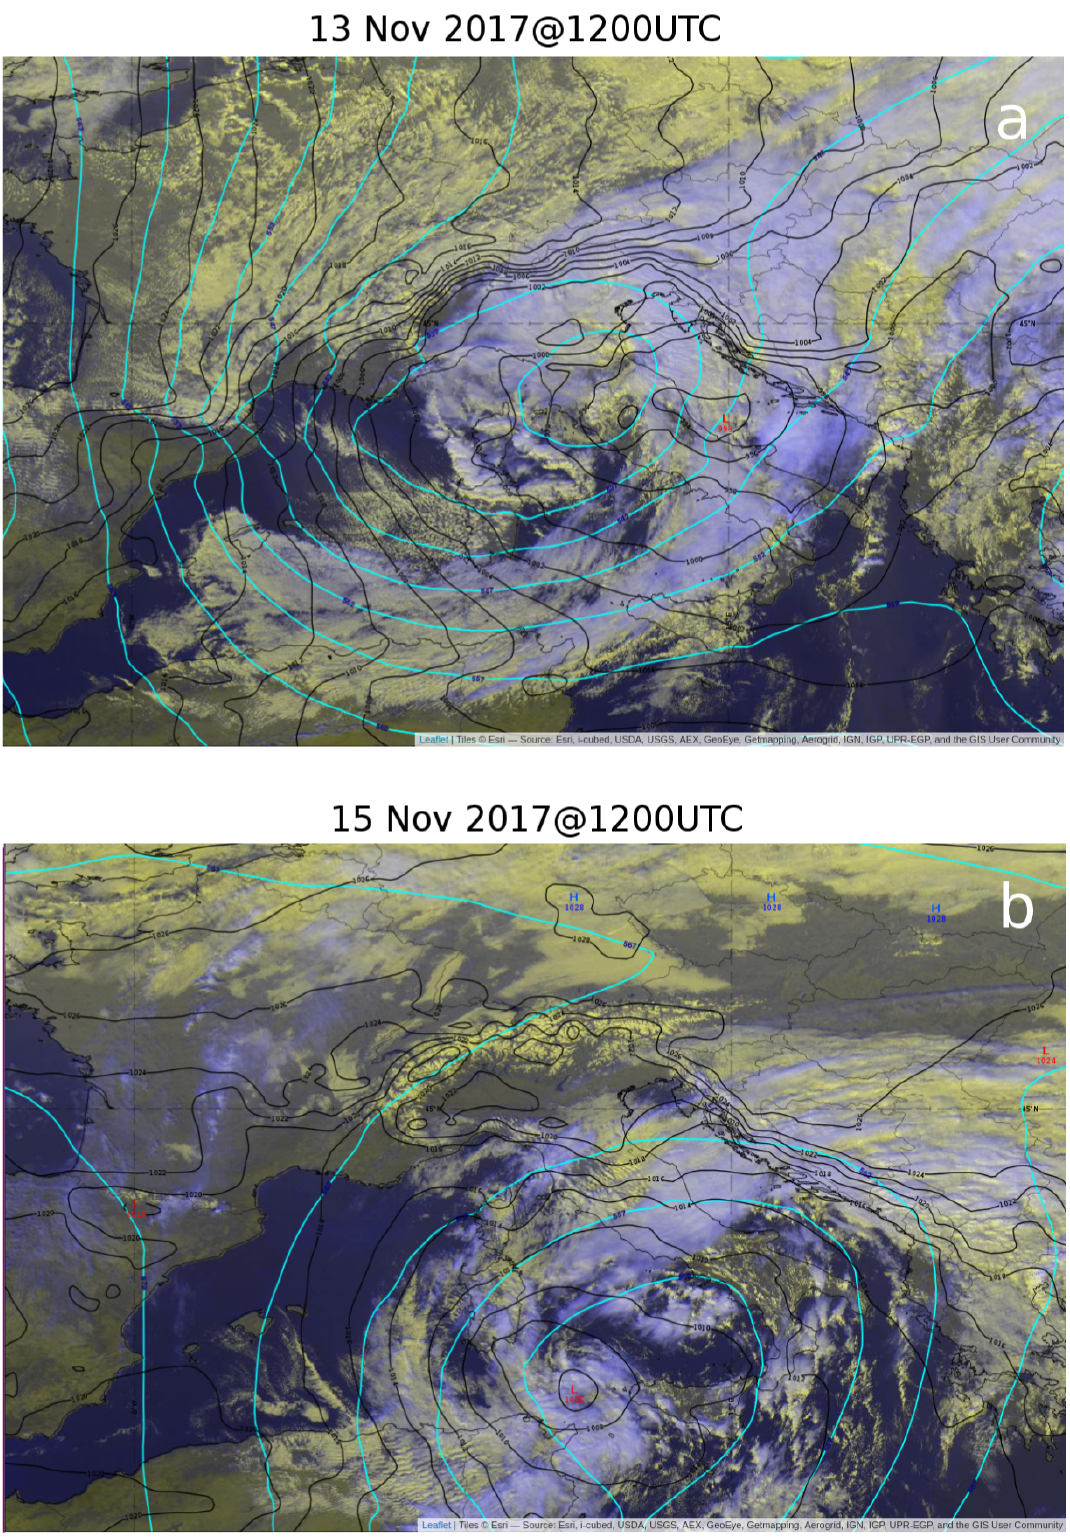
Figure 1. ECMWF analysis. Geopotential height at 500hPa (cyan lines; contour lines of 5dam) and mean sea level pressure (black lines labelled in hPa; contours lines of 20hPa) and satellite water vapour (WV) for (a) 13 November 2017 at 12:00UTC and (b) 15 November 2017 at 12:00UTC. The maps have been retrieved from the EUMeTrain (European Organisation for the Exploitation of Meteorological Satellites – EUMETSAT – international training project) ePort archive (http://eumetrain.org/eport.html, last access: 26 September